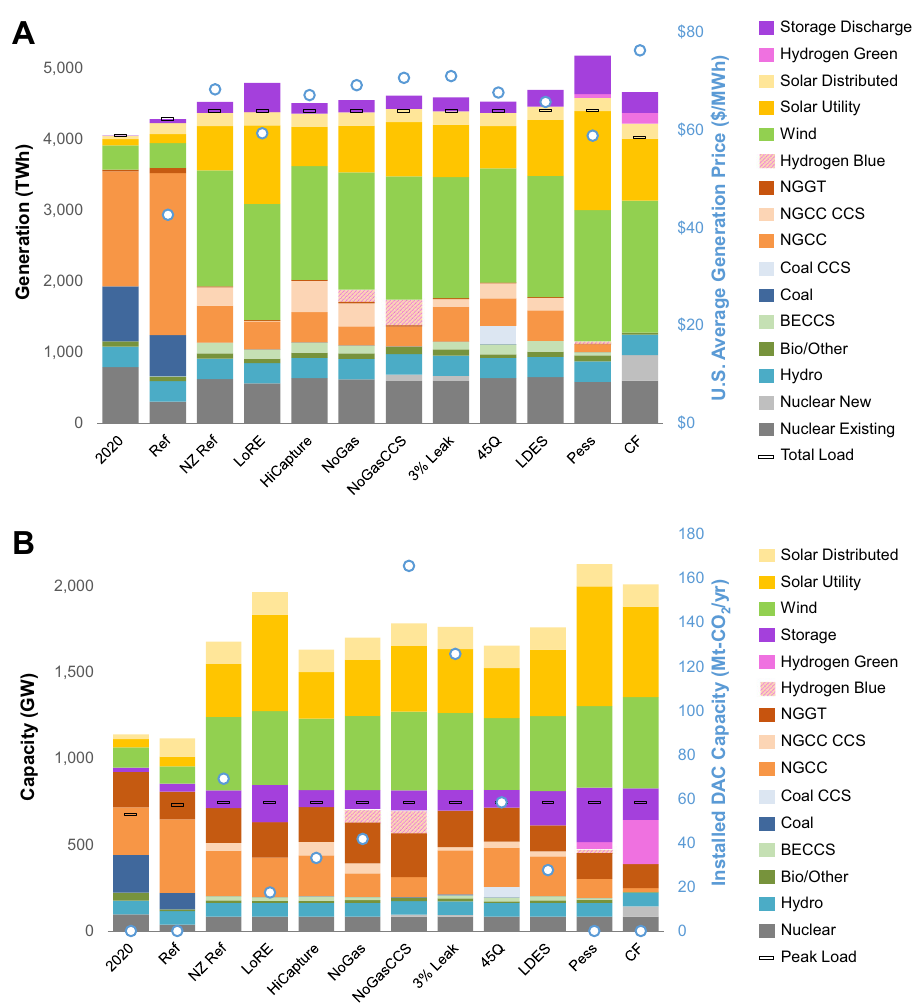
Fig. 1 | National generation and capacity by technology and scenario in 2035. A Generation in 2035 assuming net-zero-emissions targets in 2035. U.S. generation- weighted average price ($/MWh), which re fl ects all generation, new bulk transmis- sion,carbonremoval,andCO 2 transportandstoragecosts.StorageDischargerefers